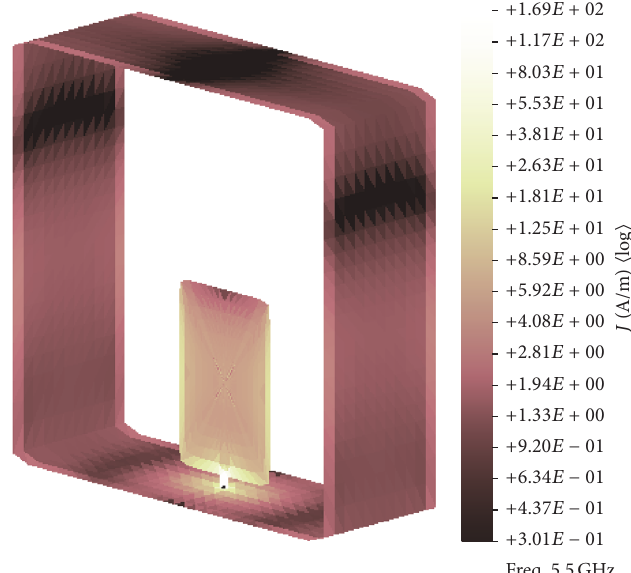
Figure 12: Current density on the proposed model at 5.5